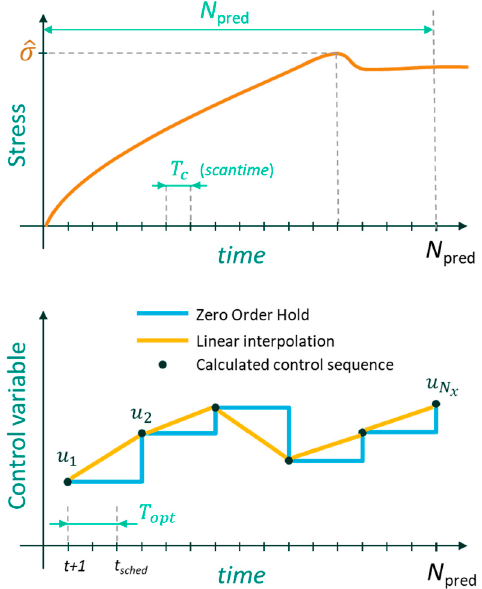
Figure 9. Details on the optimization of the problem parameters.